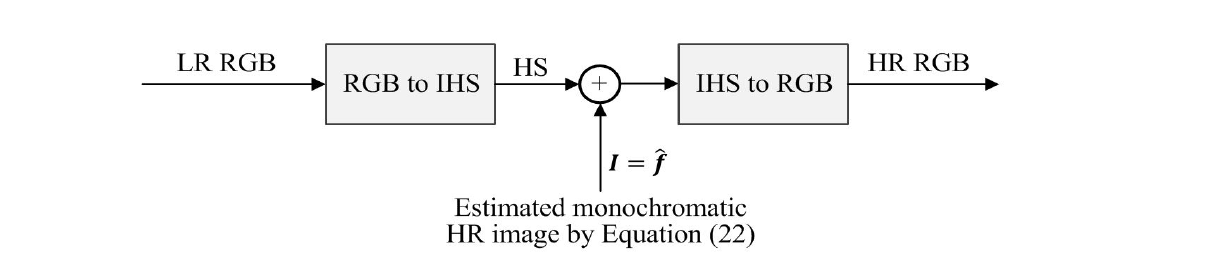
Figure 3. Block-diagram of the proposed fusion-based high-resolution (HR) color image reconstruction process.